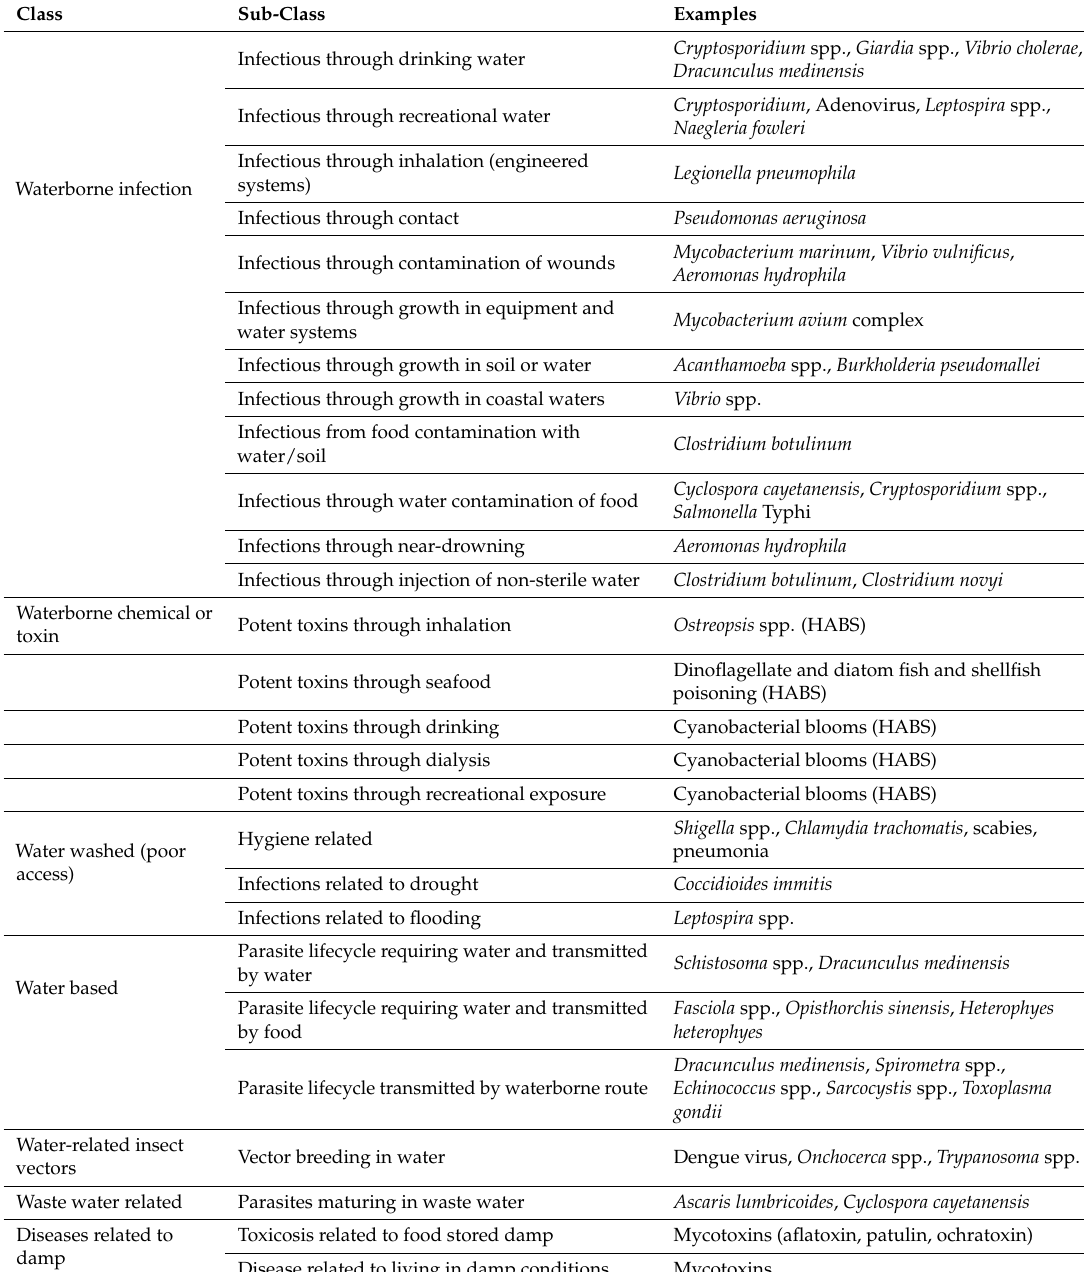
Table 1. Criteria for water-related diseases